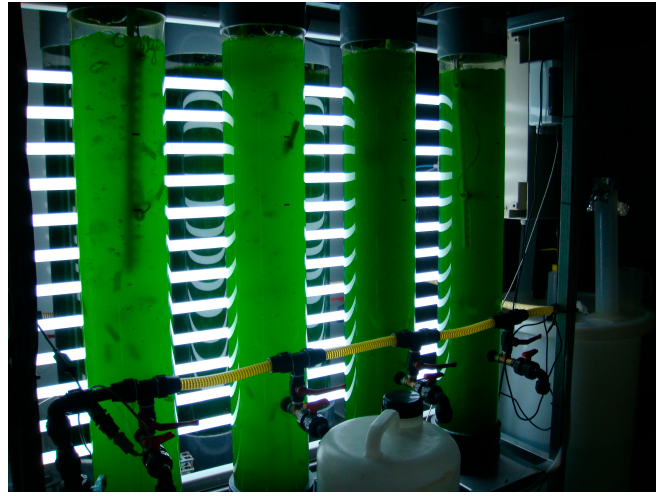
Figure 2. Photobioreactor with microalgae (Applied Physics department, University of Vigo).